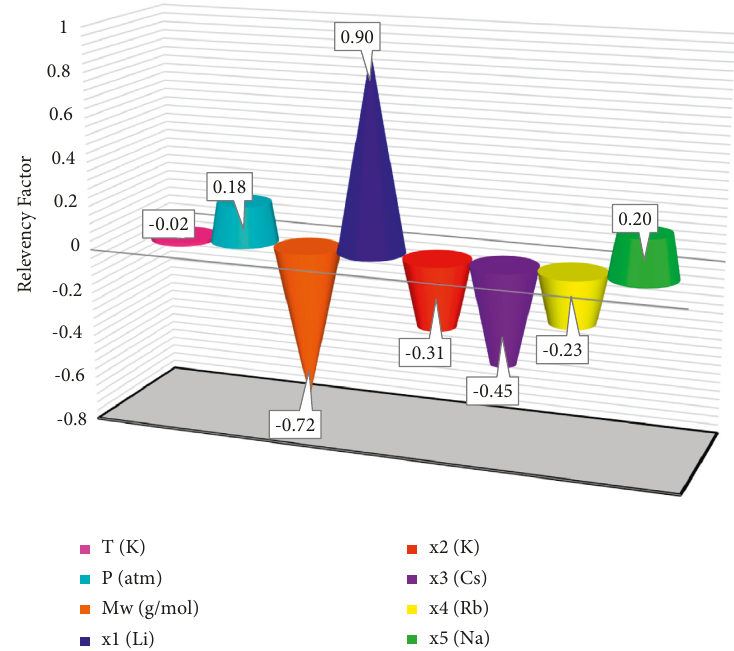
Figure 13: Sensitivity analysis for alkali metals’